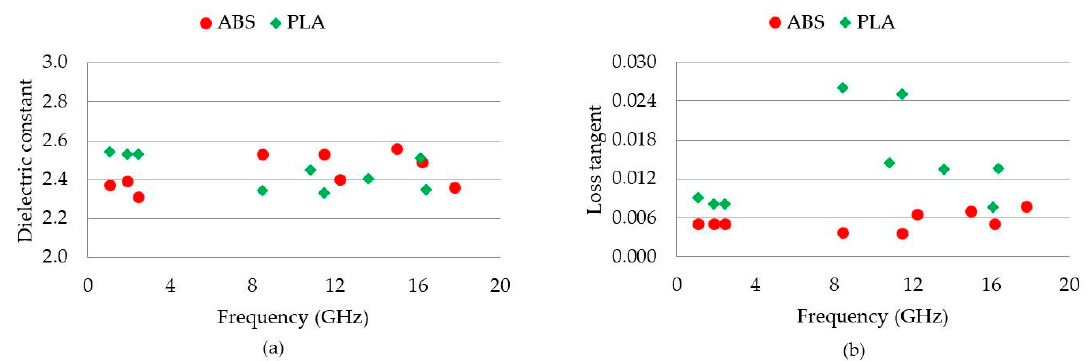
Figure 12. Measured ( a ) dielectric constant and ( b ) loss tangent of ABS and PLA MUTs at frequencies less than 20 GHz.